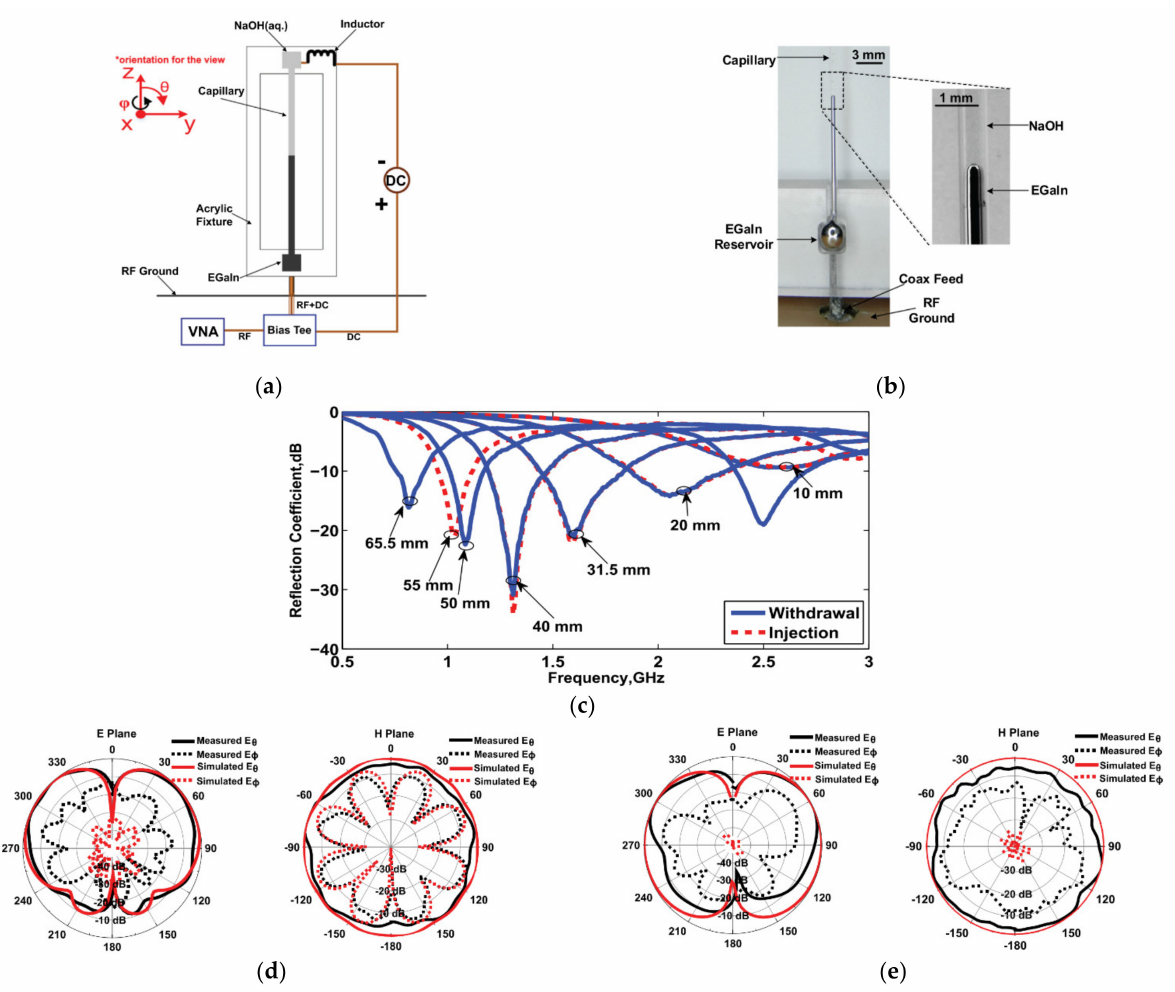
Figure 10. ( a ) Schematic of the tunable monopole antenna. ( b ) Photograph of the antenna, feed, and reservoir. ( c ) Reflection coefficient of different lengths. ( d ) Radiation patterns for 2.5 GHz with a length of 17 mm. ( e ) Radiation patterns for 0.96 GHz with a length of 55 mm. Reprinted with permission from Ref. [23]. Copyright 2015 AIP Publishing.